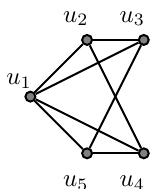
Figure 3: The graph G